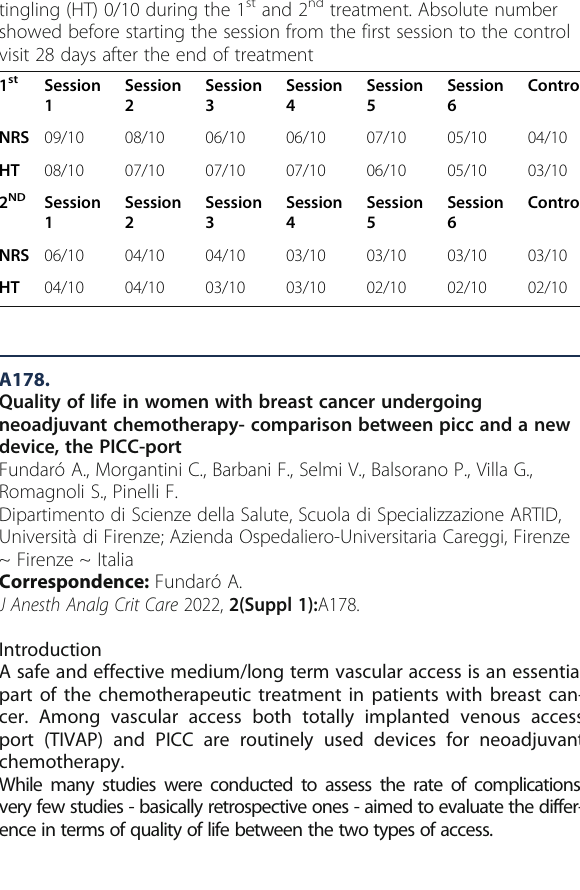
Table 1 (abstract A177). Numeric Rating Scale (NRS) 0/10 and hand tingling (HT) 0/10 during the 1 st and 2 nd treatment. Absolute